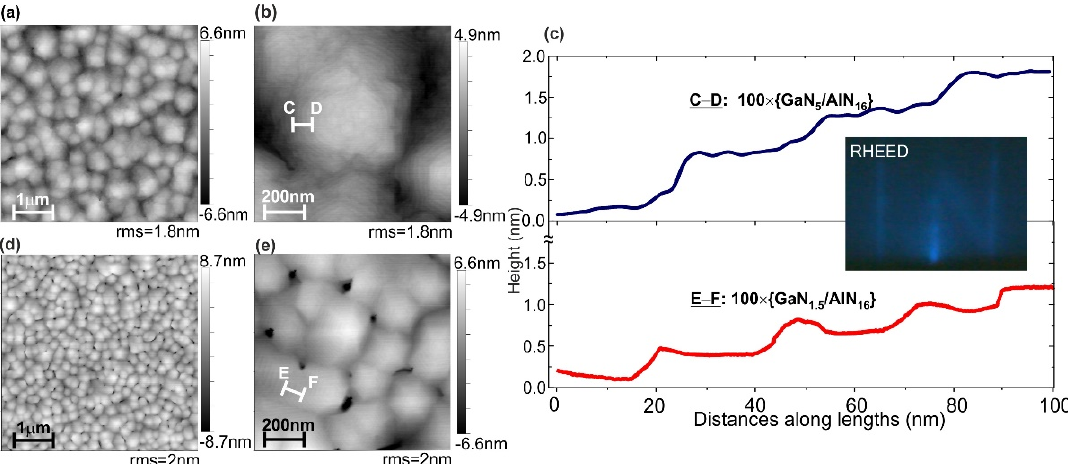
Figure 2. AFM images measured in scanned areas of 5 × 5 µm 2 ( a , d ) and 1 × 1 µm 2 ( b , e ) in the 100 × {GaN 5 /AlN 16 } ( a , b ) and 100 × {GaN 1.5 /AlN 16 } ( d , e ) MQW structures. ( c ) Blue and red lines indicate surface height profiles measured along C-D and E-F lengths in images ( b ) and ( e ), respectively. The inset shows a typical RHEED image observed during the growth of the MQW structures.